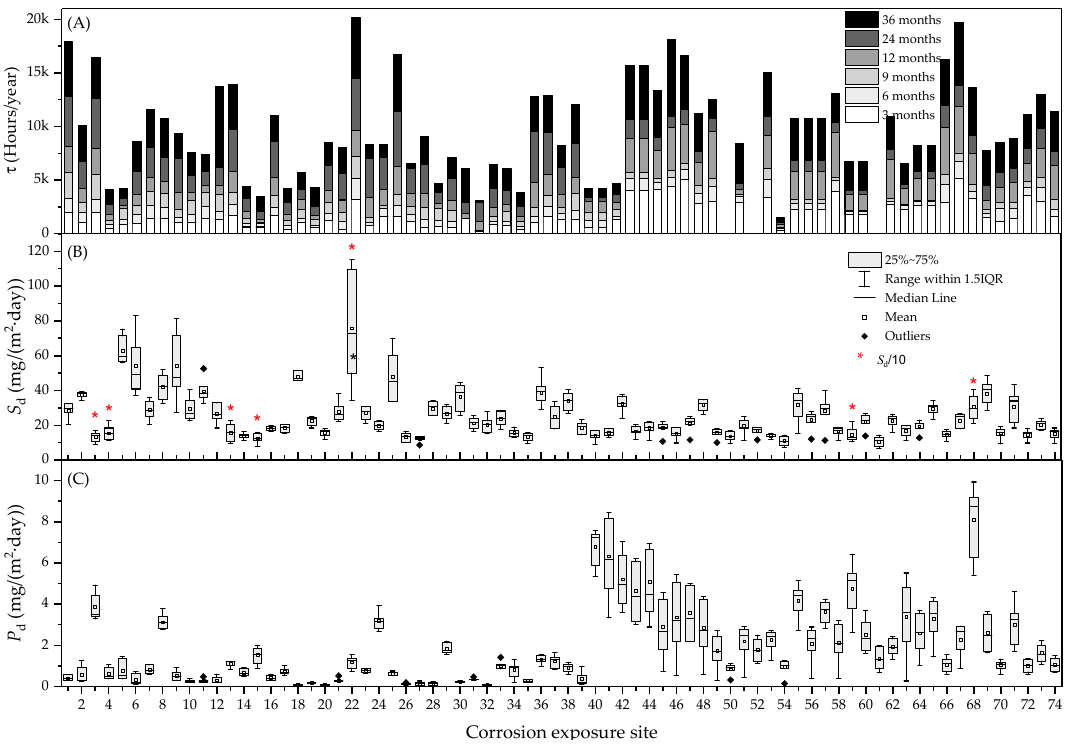
Figure 3. Local environmental conditions at the 74 corrosion exposure sites determined during 3 years. ( A ) Time of wetness, ( B ) average Cl − deposition, and ( C ) average SO 2 Table 2. Environmental parameters and levels employed in the ANOVA analysis. Environmental Parameter